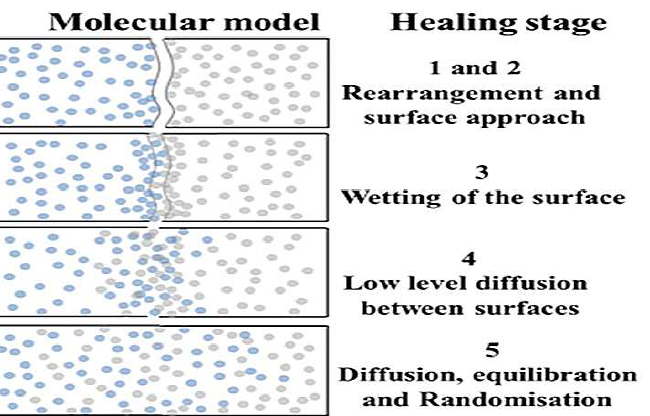
Figure 1. Self-healing process of polymer molecular model. Adapted with permission from [7]. Copyright 2021 Elsevier.